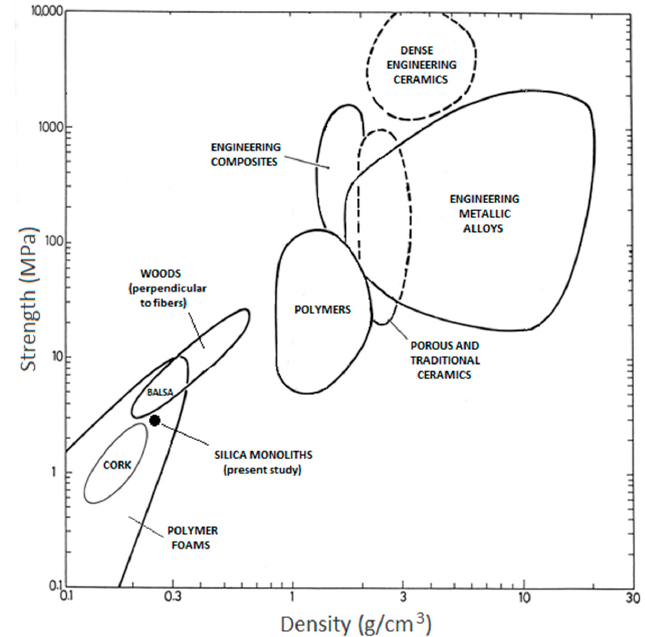
Figure 11. Comparison of the hierarchical silica monoliths of the present study (black bullet) with different classes of materials in a strength–density chart. Following Ashby’s representation [34], “strength” stands for either compressive strength (brittle materials), tensile strength (composites) or yield stress (metals).